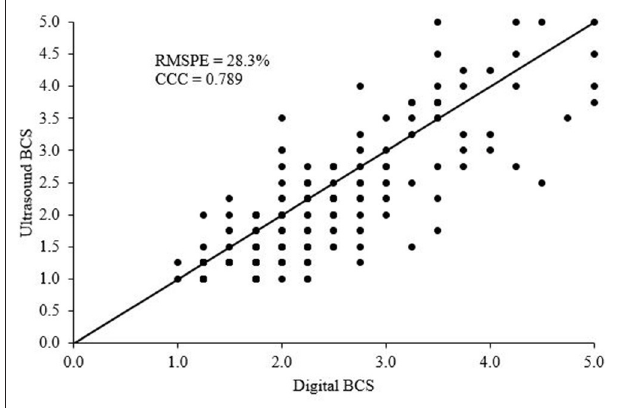
FIGURE 6 | C lassification of digital measure of tail head to pin bones width into 17 body condition scores (BCS).